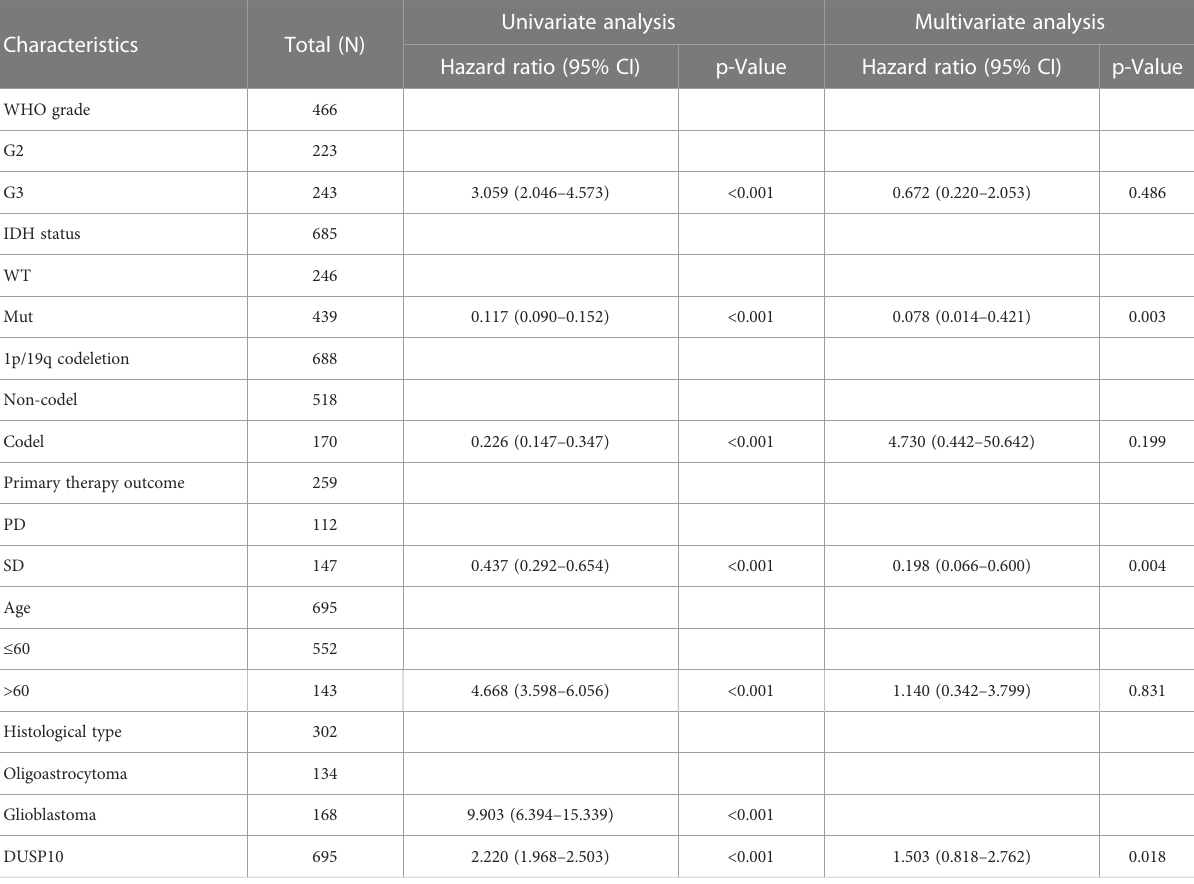
TABLE 2 Univariate and multivariate analyses of DUSP10 and clinical features in TCGA datasets.